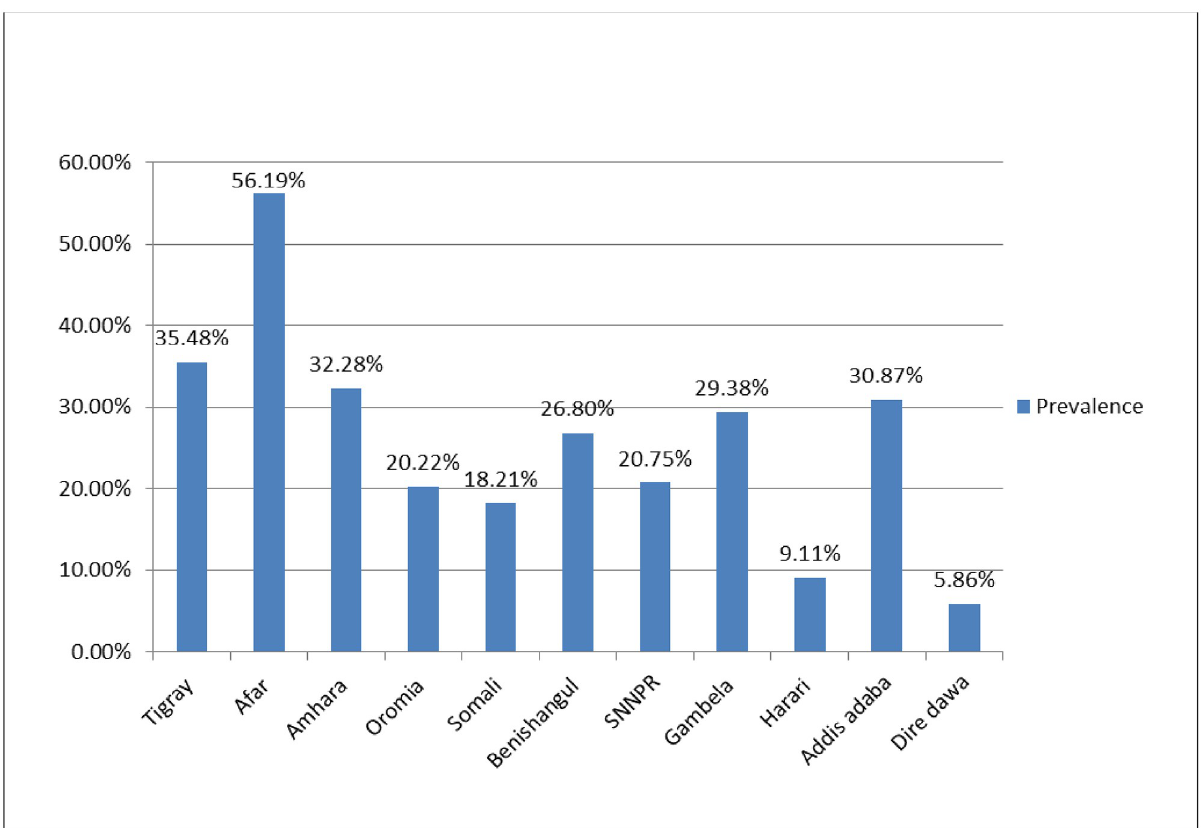
Fig 2. Prevalence of delayed initiation of breastfeeding across regions in Ethiopia,